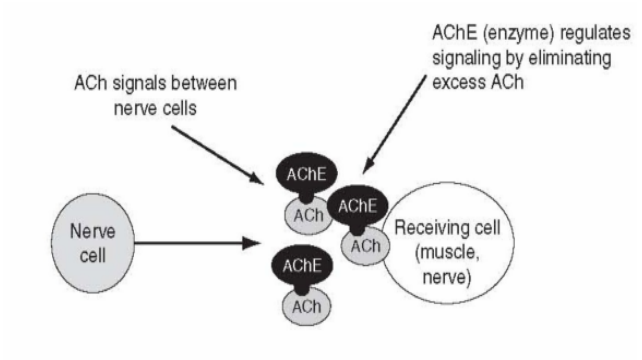
Figure 2: Normal nerve signals [38]